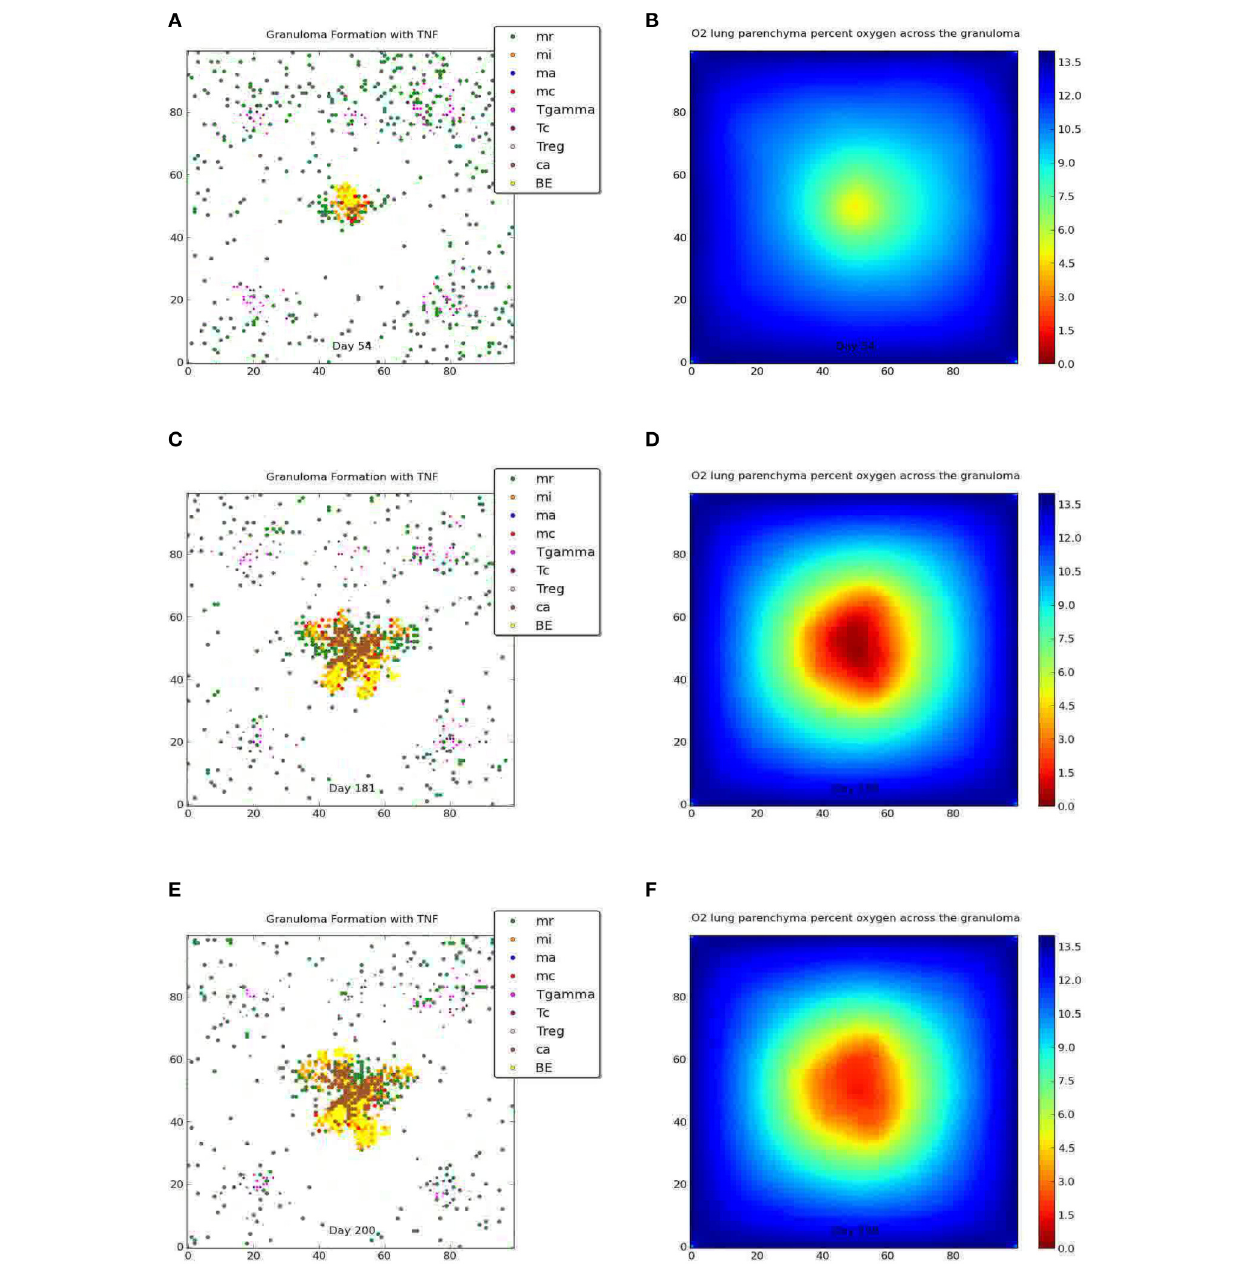
FIGURE 8 | Dissemination and the corresponding oxygen field at 54, 181, and 200 days post-infection. Severe hypoxia is seen on day 181, which resolves by day 200.